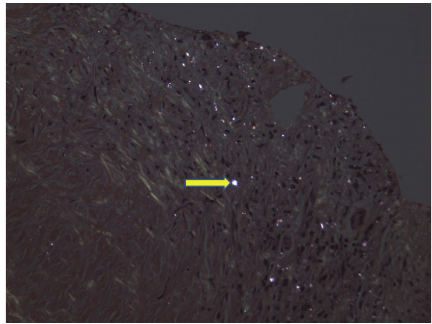
Figure 4: Lung biopsy underpolarized microscopy showing bright white silica crystals of varying